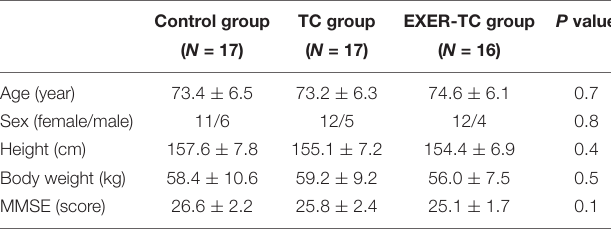
MMSE: Mini-Mental State